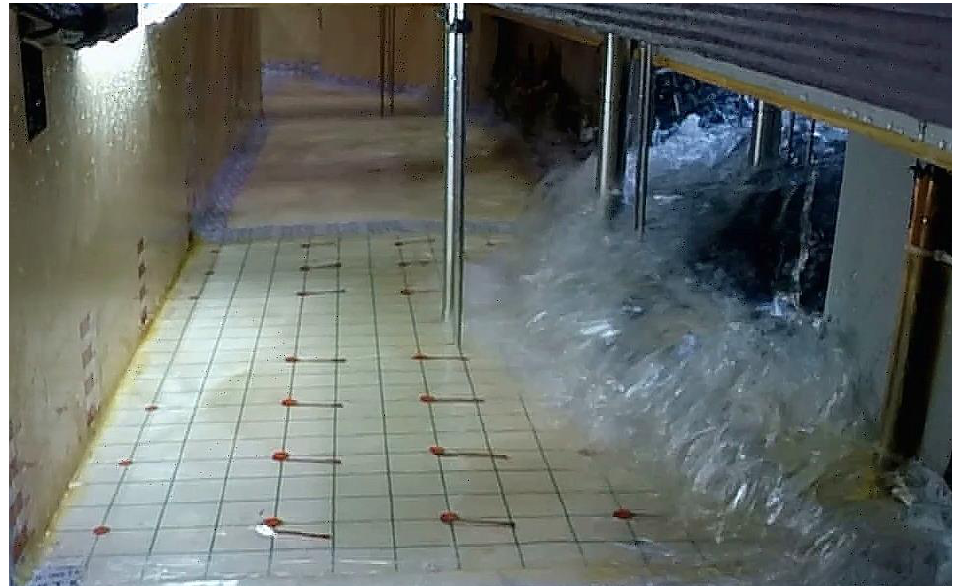
Figure 4. View on the vehicle deck of the ship model through a ship-fixed camera (1/3). Floodwater can be seen flowing massively in through the damage opening on the starboard, wave side of the vessel. On the deck, there are sensors for measurement of the flow speed and water elevation. The red tufts on the deck for flow direction visualization are still all pointing towards the damage opening, as a result of floodwater flown out just before the present wave came in.